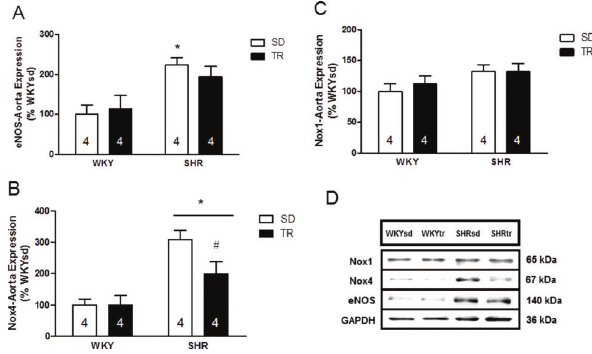
Figure 4 - Densitometry analysis of the levels of the eNOS, * p =0.002 SHRsd group compared with WKY (A); Nox4, * p =0.001 SHR compared with WKY and # p =0.02 SHRtr group compared with the SHRsd group (B); and Nox1 proteins (C). Representative blots (D) of samples of the aortas from the WKYsd, WKYtr, SHRsd and SHRtr groups. The data are presented as the mean ± SEM.